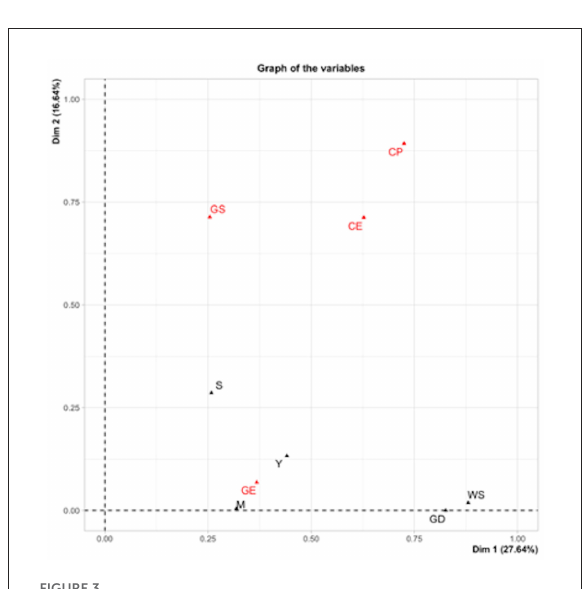
FIGURE3 Mixed factor analysis, contribution of the variables that ordered the accessions according to the qualitative and quantitative